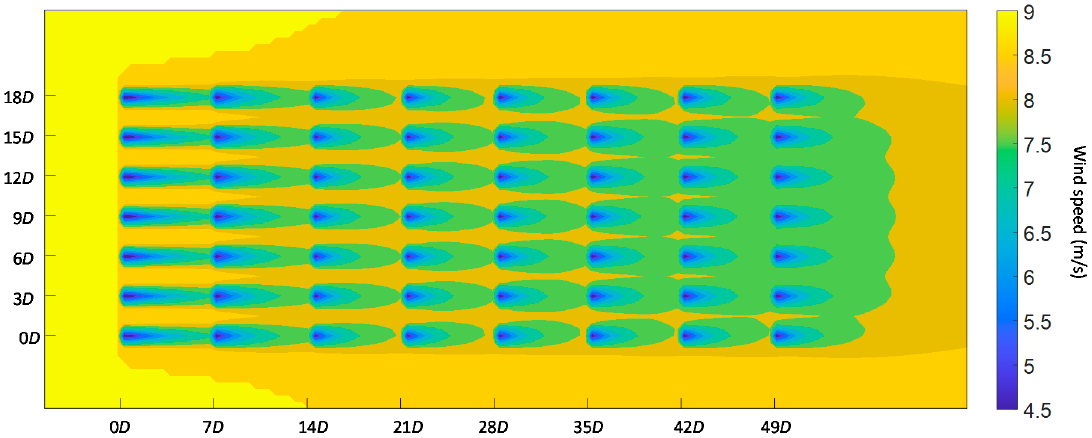
Figure 8. Wind speed field corresponding to the optimal solution obtained by the proposed algorithm.